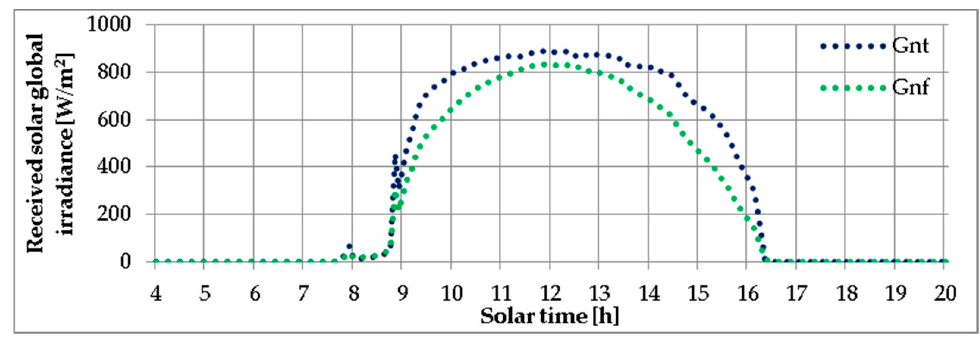
Figure 13. Solar global irradiance received by the tracked ( G nt ) and fixed ( G nf ) PV platforms on 12 January 2022.